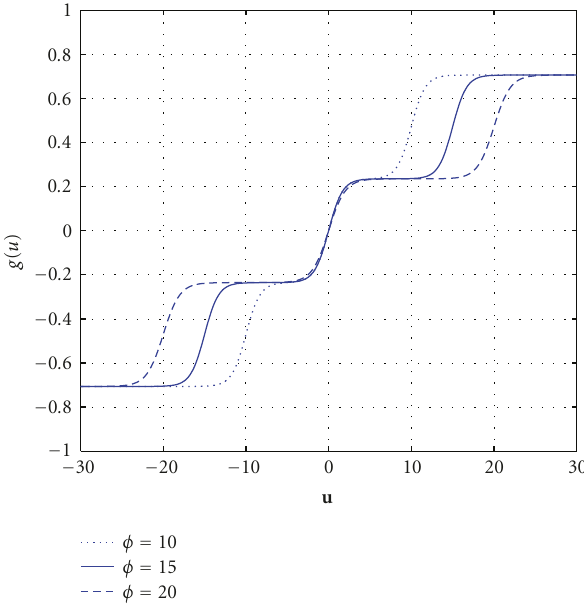
Figure 4: The four-level decision